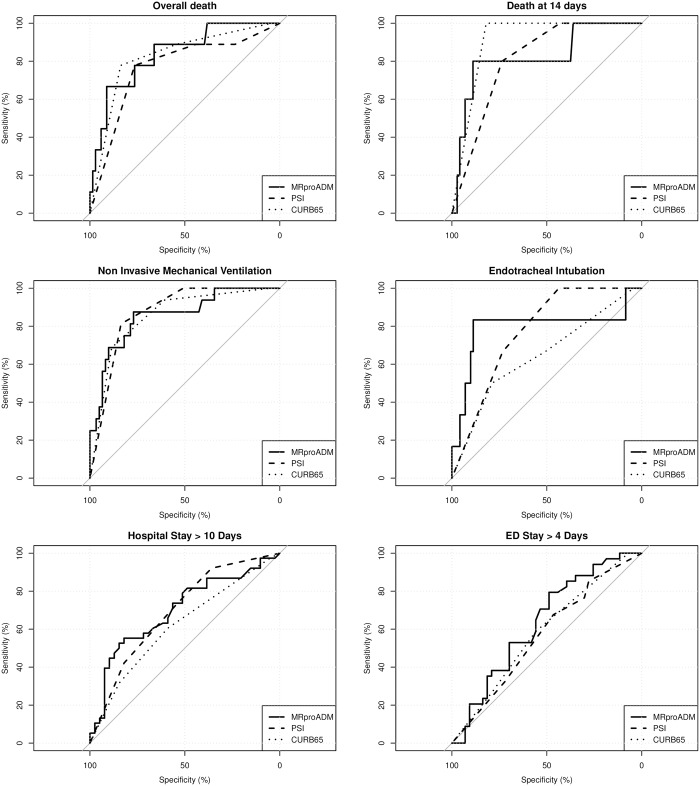
MR-pro-ADM prediction in relation to study outcomes: AUC with a 95% CI for each predictor MR-pro-AMD, CURB65 and PSI, by main endpoint.From upper left panel to lower right panel: overall death (CURB65: AUC [95% CI] = 0.824 [0.685–0.964], PSI: AUC [95% CI] = 0.766 [0.598–0.934], MRproADM: AUC [95% CI] = 0.837 [0.704–0.970]), death at 14 days (CURB65 –AUC [95% CI] = 0.910 [0.865–0.954], PSI:AUC [95% CI] = 0.811 [0.696–0.926], MRproADM: AUC [95% CI] = 0.824 [0.617–0.998]), non-invasive mechanical ventilation CURB65 –AUC [95% CI] = 0.855 [0.762–0.948], PSI: AUC [95% CI] = 0.872 [0.801–0.943], MRproADM: AUC [95% CI] = 0.858 [0.750–0.960]), endotracheal intubation (CURB65:AUC [95% CI] = 0.647 [0.418–0.875], PSI: AUC [95% CI] = 0.772 [0.648–0.896], MRproADM: AUC [95% CI] = 0.793[0.535–0.997]), total hospital stay>10 days (CURB65: AUC [95% CI] = 0.618 [0.502–0.735], PSI: AUC [95% CI] = 0.695 [0.582–0.807], MRproADM—AUC [95% CI] = 0.698 [0.580–0.817]), ED stay over 4 days (CURB65: AUC [95% CI] = 0.584 [0.466–0.702], PSI:AUC [95% CI] = 0.568 [0.444–0.691], MRproADM: AUC [95% CI] = 0.635 [0.512–0.758].